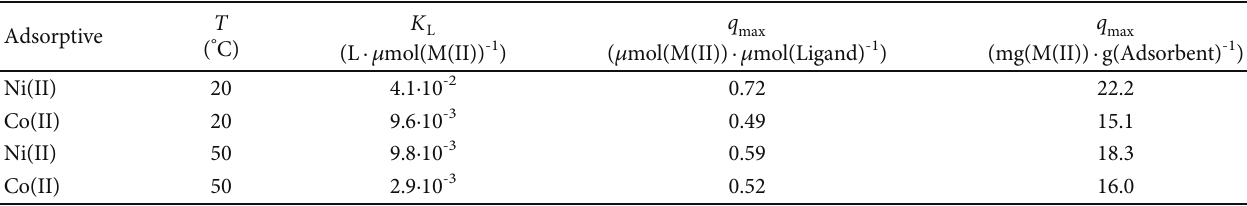
, q ) depending on adsorptive and temperature. L max